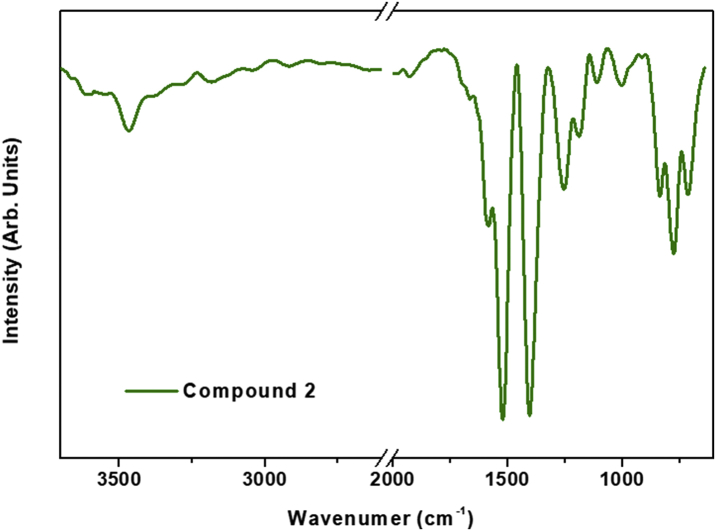
Infrared spectrum for [Pr(4-OHBBA)3(H2O)2] compound.